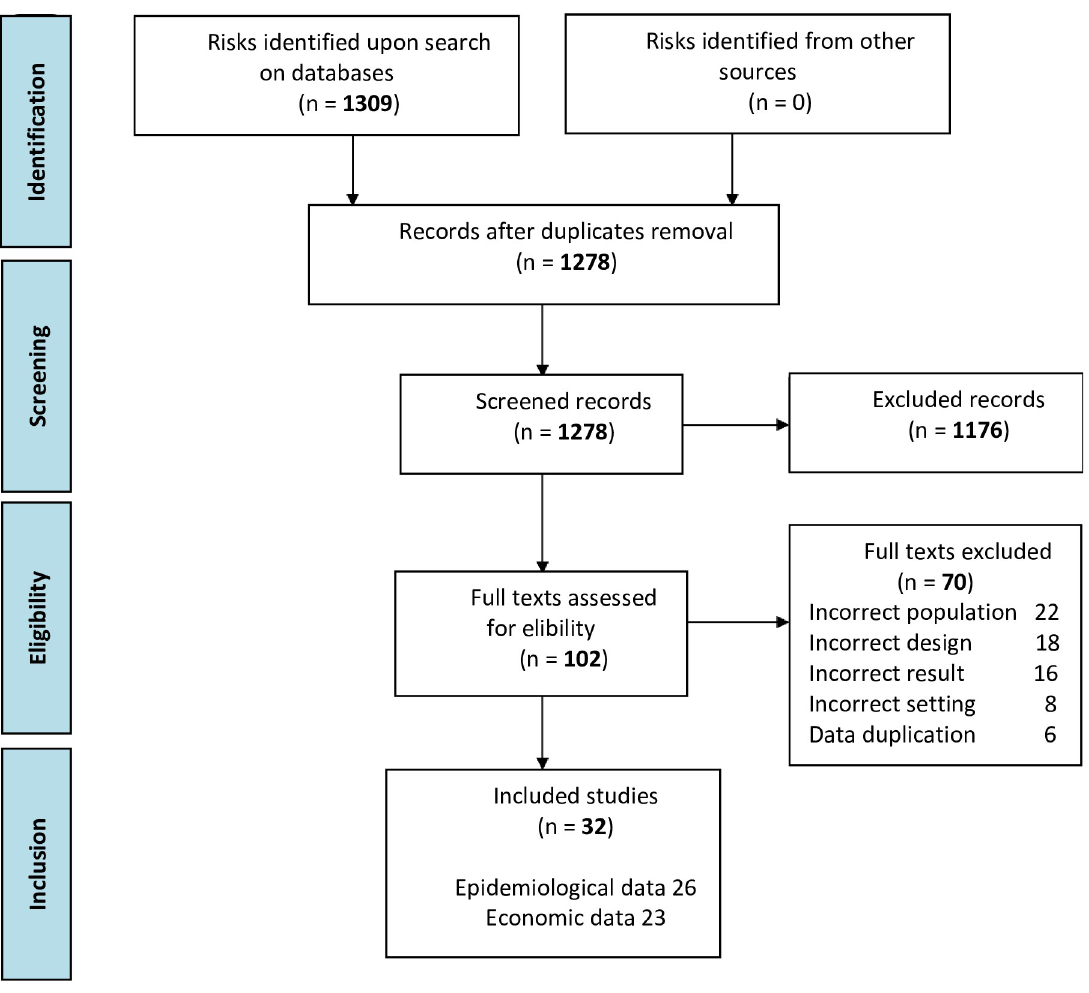
Fig 1. PRISMA flow